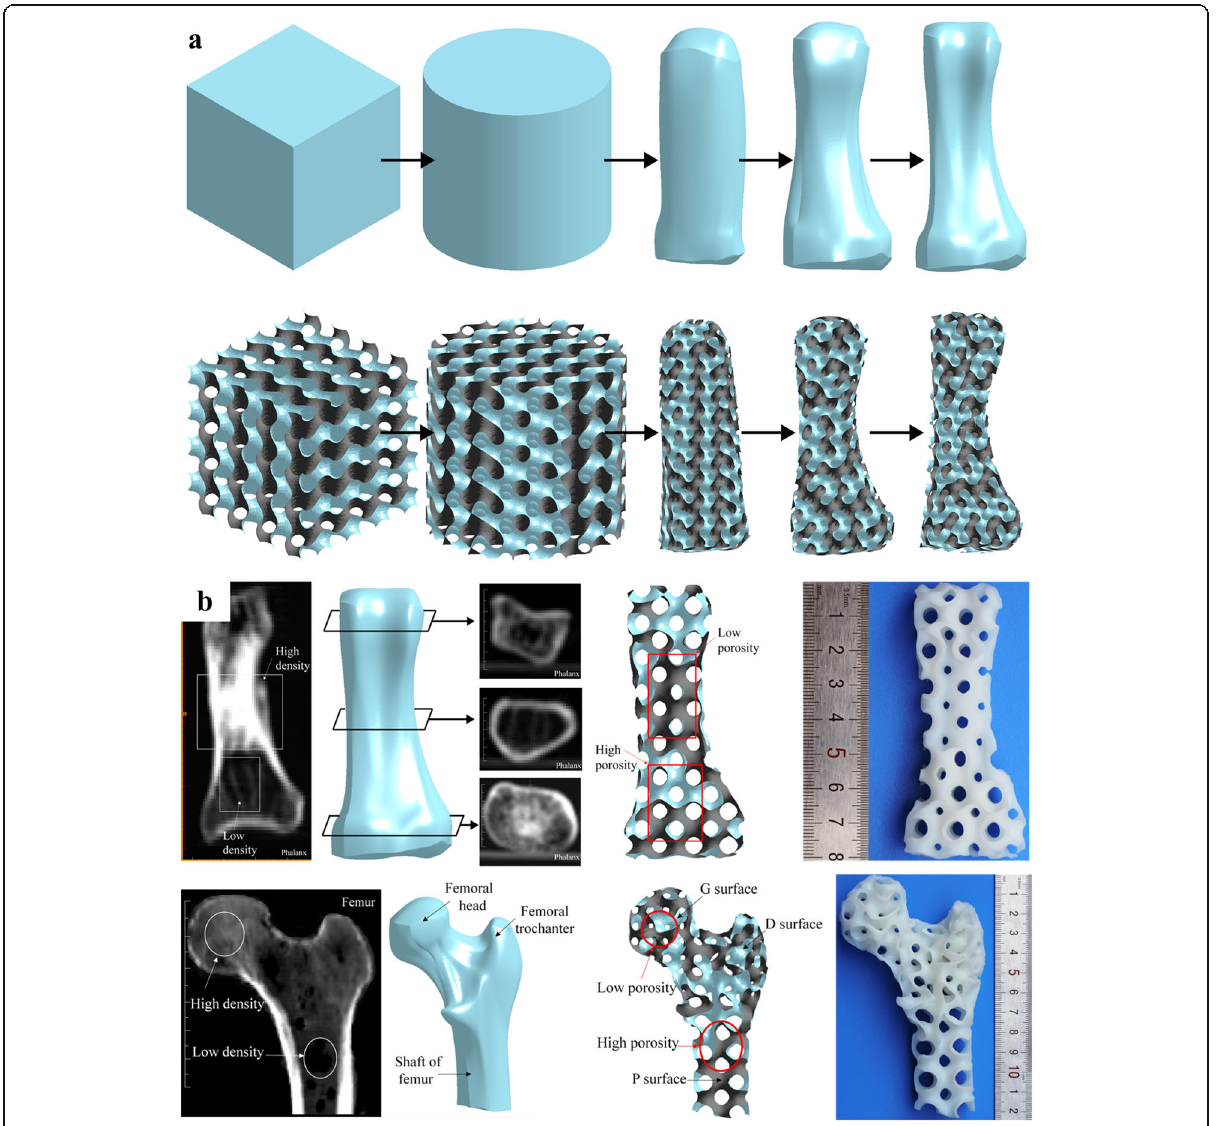
Fig. 11 Porous scaffold design by solid T-splines and TPMS: a External shape design. b Internal structure design